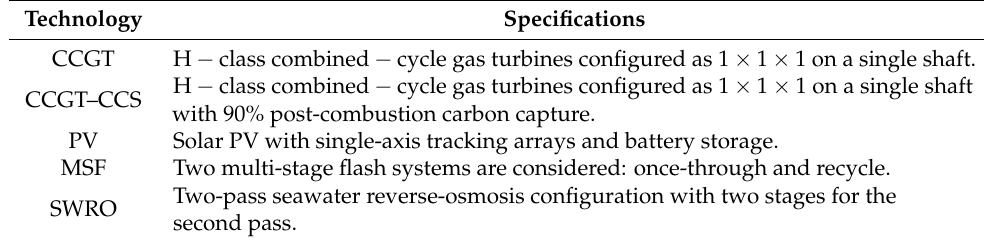
Table 3. Specifications for selected technologies.